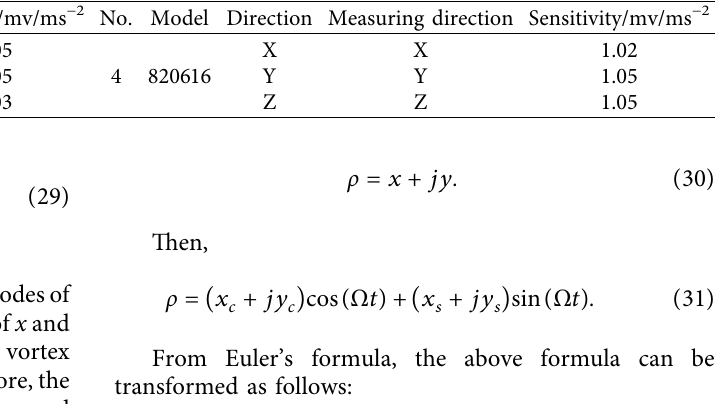
Figure 5: Dynamic signal acquisition instrument and three-way acceleration sensor. Table 1: Sensors model and sensitivity in various